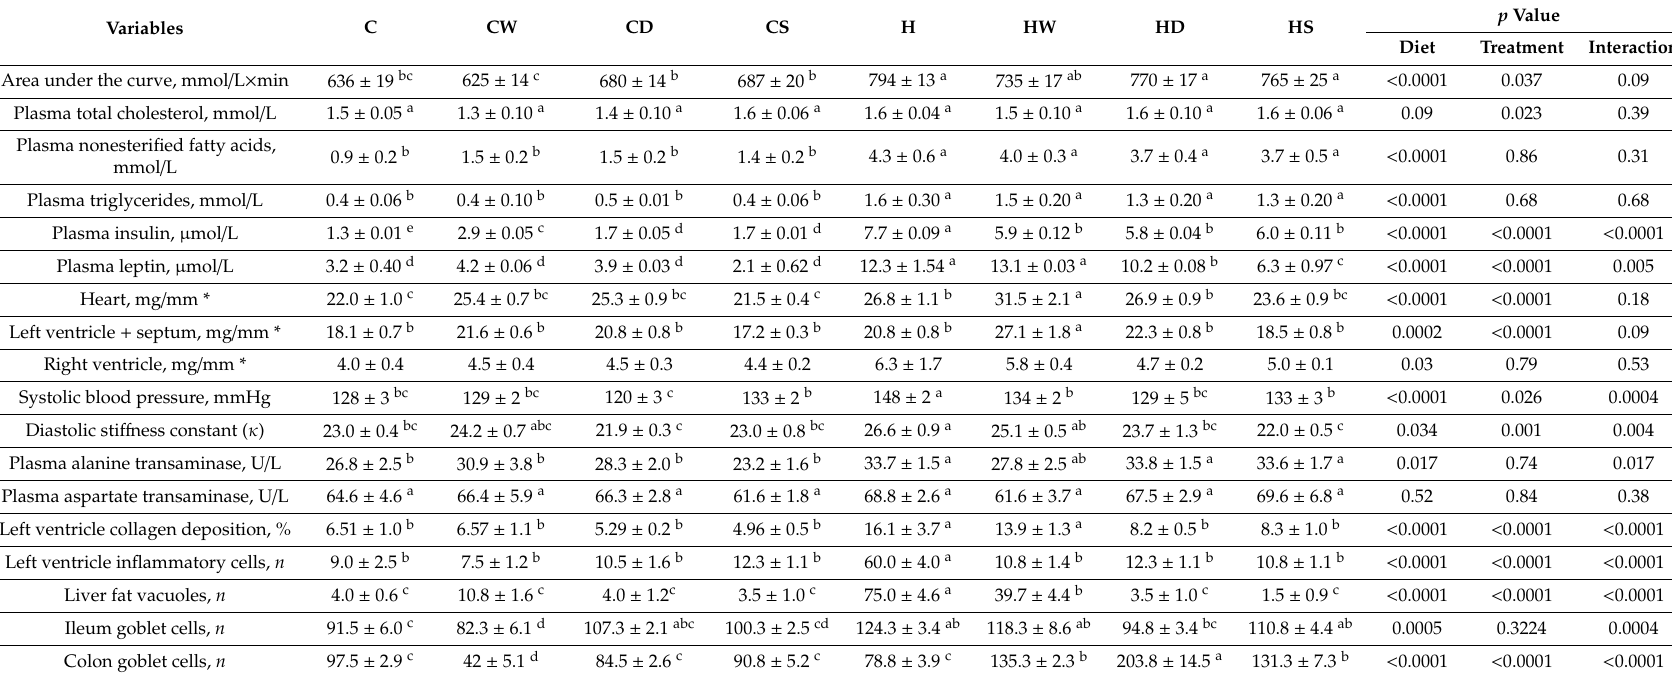
Table 2. Metabolic, cardiovascular, and liver